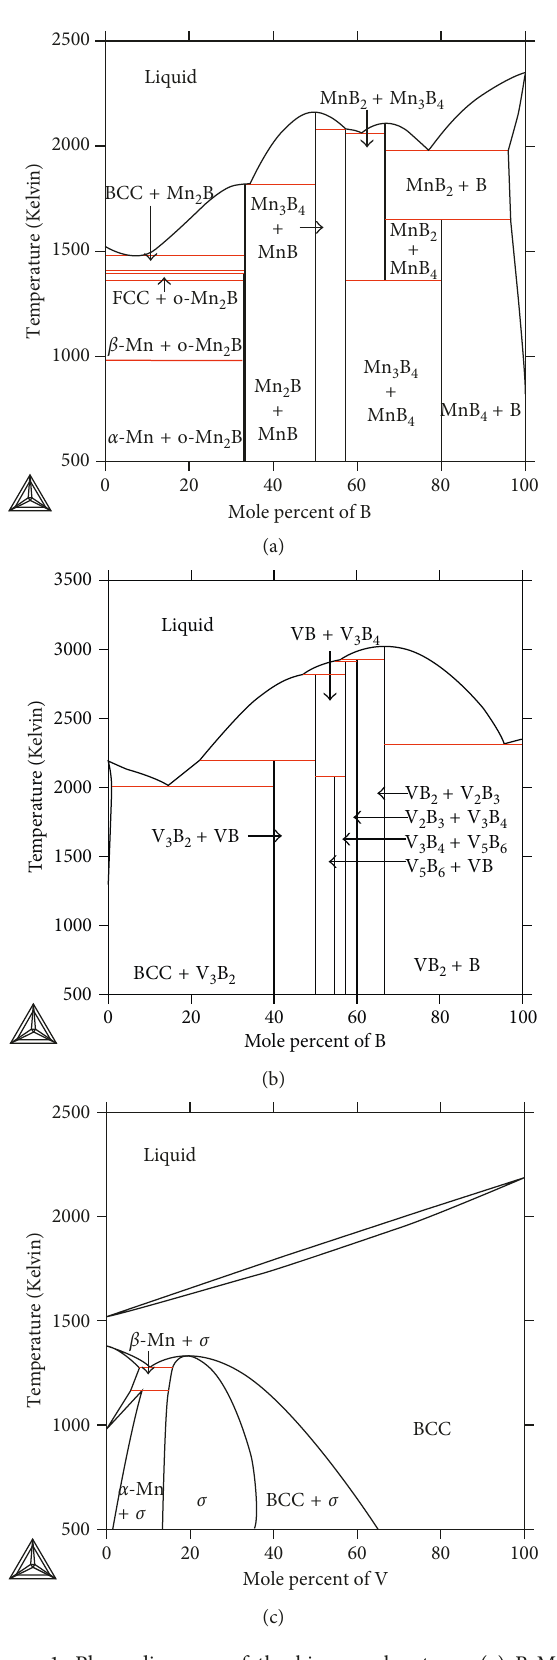
Figure 1: Phase diagrams of the binary subsystems: (a) B-Mn, (b) B-V, and (c) Mn-V.